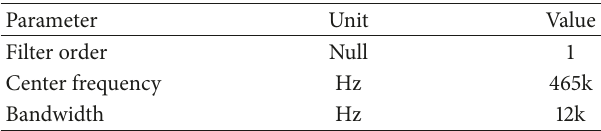
Table 1: Parameter of IF